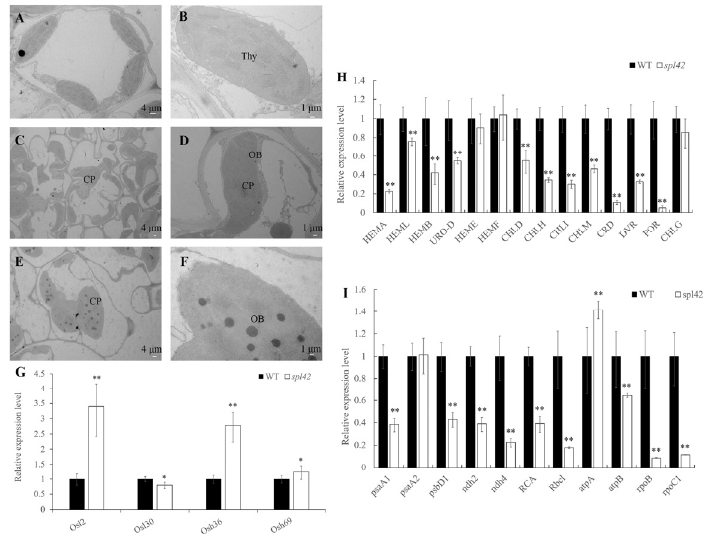
Figure 2. Transmission electron microscopic observation of the wild type (WT) and the spl42 mutant and related gene expression analysis. ( A , B ) Chloroplast ultrastructure of wild-type leaves at four-leaf stage. Scale Bar = 4 μ m in ( A ) and 1 μ m in ( B ). ( C , D ) Ultrastructure of the chloroplast in green part of leaves of spl42 at four-leaf stage. Scale Bar = 4 μ m in ( C ) and 1 μ m in ( D ). ( E , F ) Ultrastructure of the chloroplast in the spotted part of spl42 at the four-leaf stage. Thy: thylakoid lamellar; CP: chloroplast; OB: osmophilic. Scale Bar = 4 μ m in ( E ) and 1 μ m in ( F ). ( G ) Relative expression analysis of the genes related to leaf senescence in the wild type and the spl42 mutant. Error bars represent ± SD ( n = 3). ( H ) Relative expression analysis of the genes related to chloroplast development in the wild type and the spl42 mutant. Error bars represent ± SD ( n = 3). ( I ) Relative expression analysis of the genes related to chlorophyll biosynthesis in the wild type and the spl42 mutant. Error bars represent ± SD ( n = 3). Asterisks indicate a significant difference between WT and the spl42 plants by Student’s t -test, ** p < 0.01; * p <